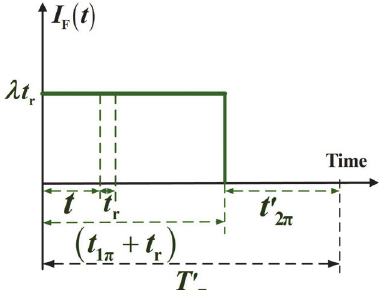
Fig. 2. The safety stock level in condition 1 of the proposed